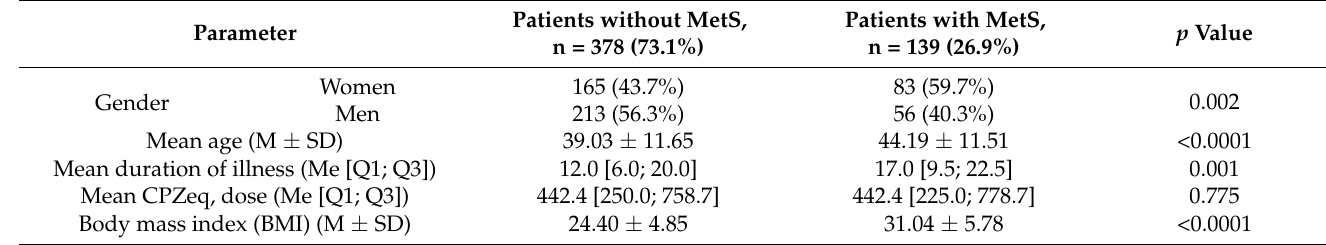
Table 1. Demographic and clinical parameters of the studied patient groups.